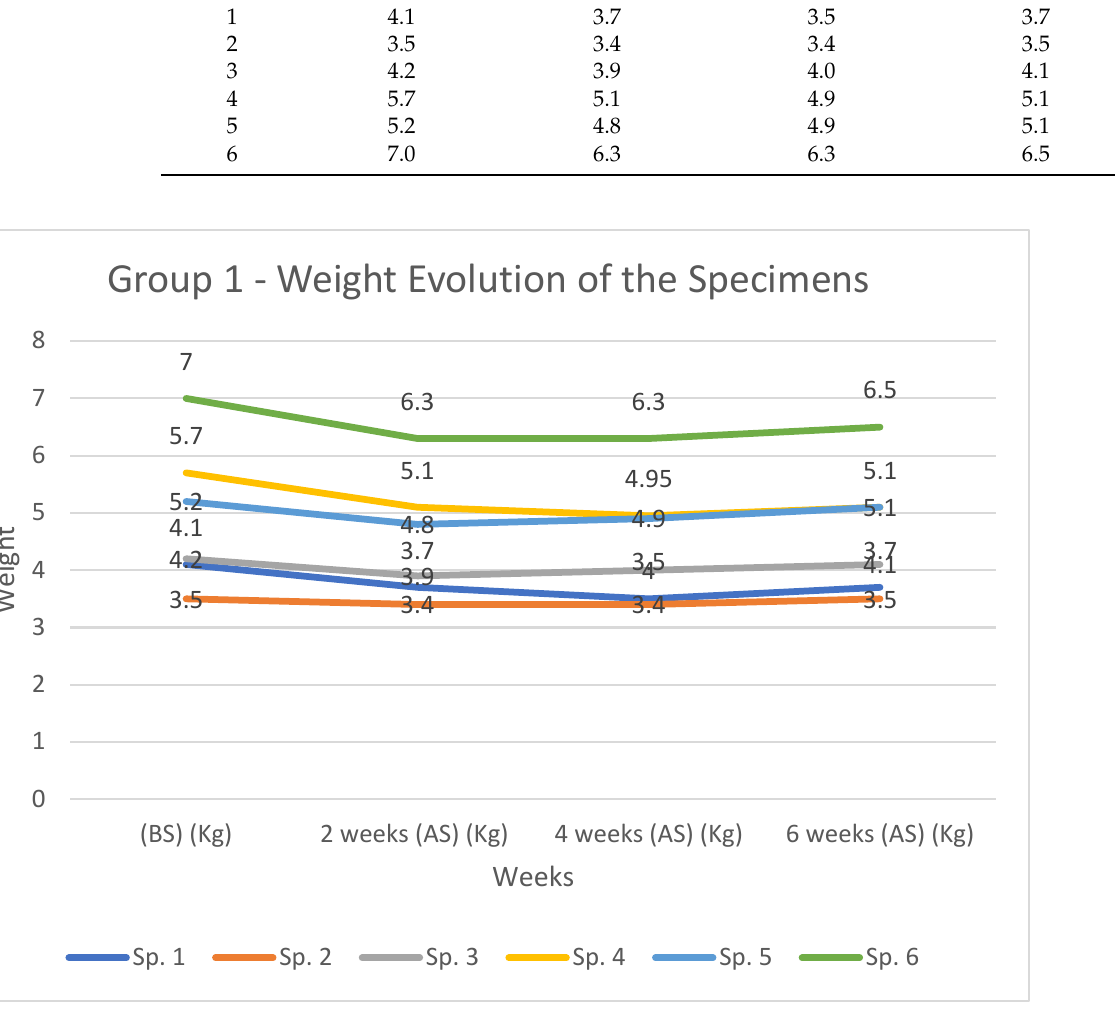
Figure 11. Weight distribution and comparison amongst cases from group 1 at 2, 4, and 6 weeks (AS) as well as (BS). Table 5. Weight distribution of the cases, before and after surgery, in group two.